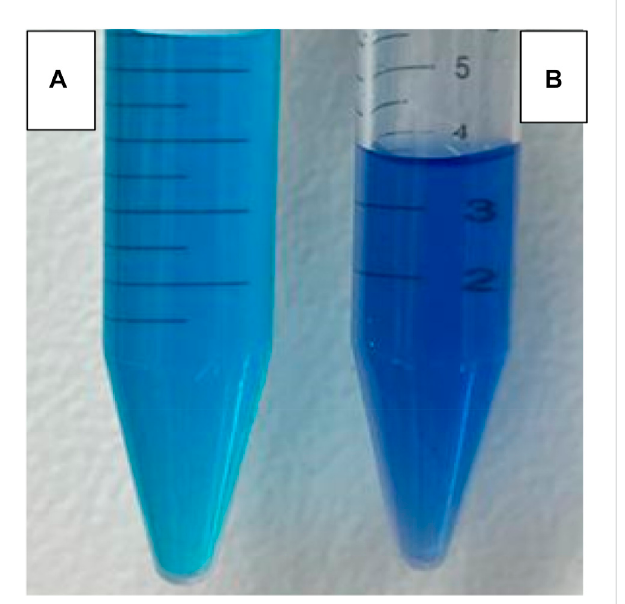
Change in MB color (A) without addition of CaO and (B) upon addition of 0.05 g CaO after 24 h.